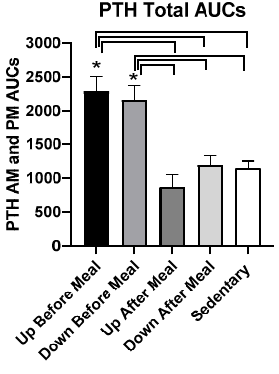
Figure 12. Total postprandial PTH AUCs in the five trials. AUCs in the two exercise-before-meal trials were significantly higher than in the SED trial, and total PTH AUC in the DAM exercise-after-meal trial was significantly higher than in the UAM trial. PTH AUCs in the morning and afternoon postprandial periods were not significantly different. * indicates significant difference relative to groups marked by the overhead bracket